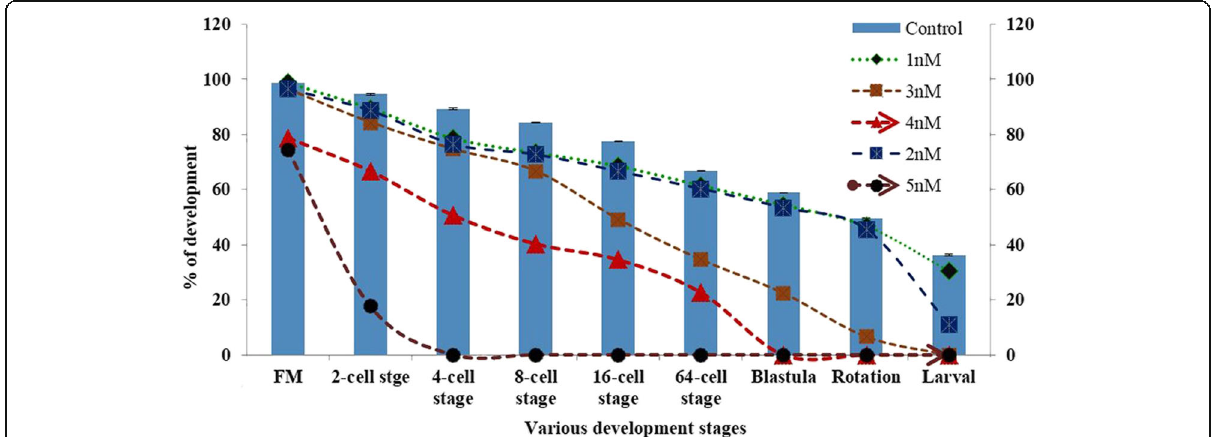
Fig. 6 Percentage of Hydroides elegans in early developmental stages with different concentrations of silver nanoparticles. The mean difference is significant when compared to control (* P < 0.05